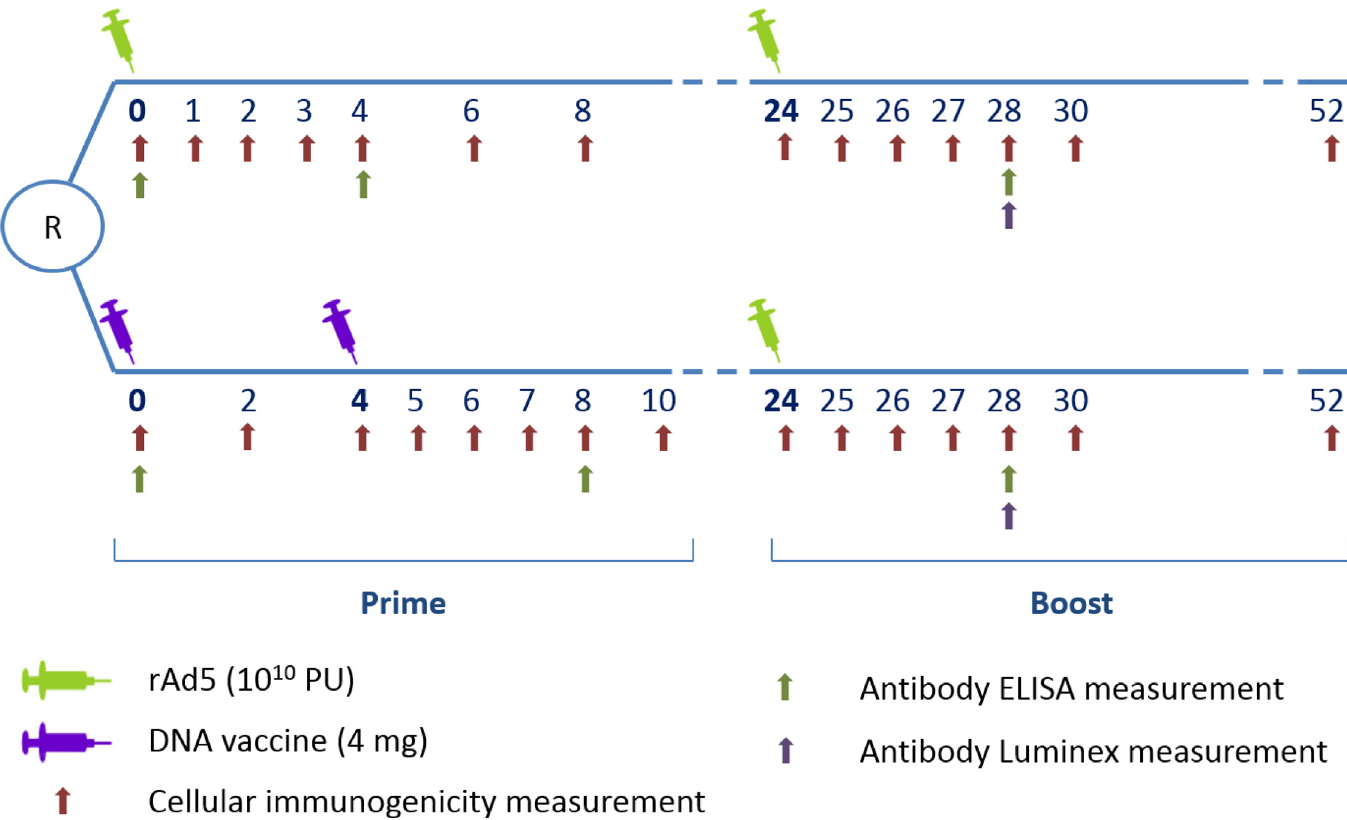
Fig 1. HVTN 068 trial design with repeated immunogenicity measurements – cellular and antibody responses — during the 52 weeks of follow-up.